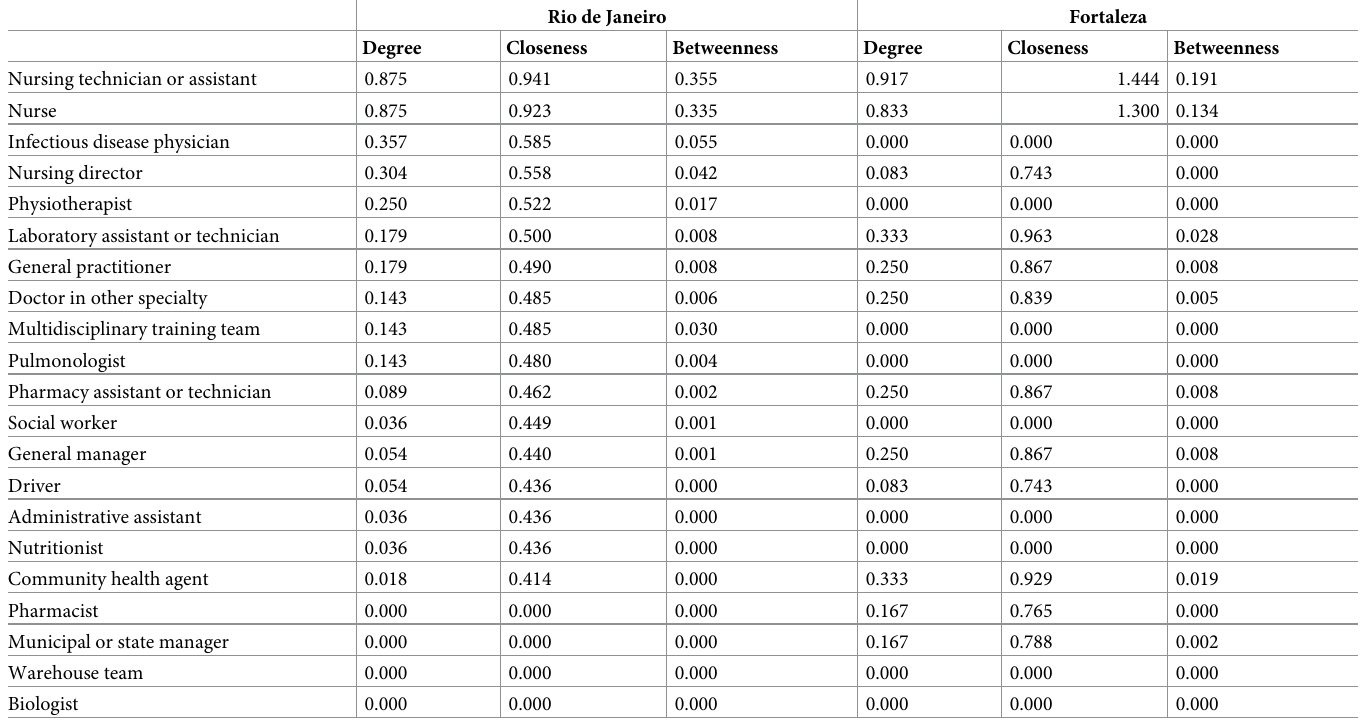
Table 2. Centrality measures of nursing technicians’ social network–Rio de Janeiro and